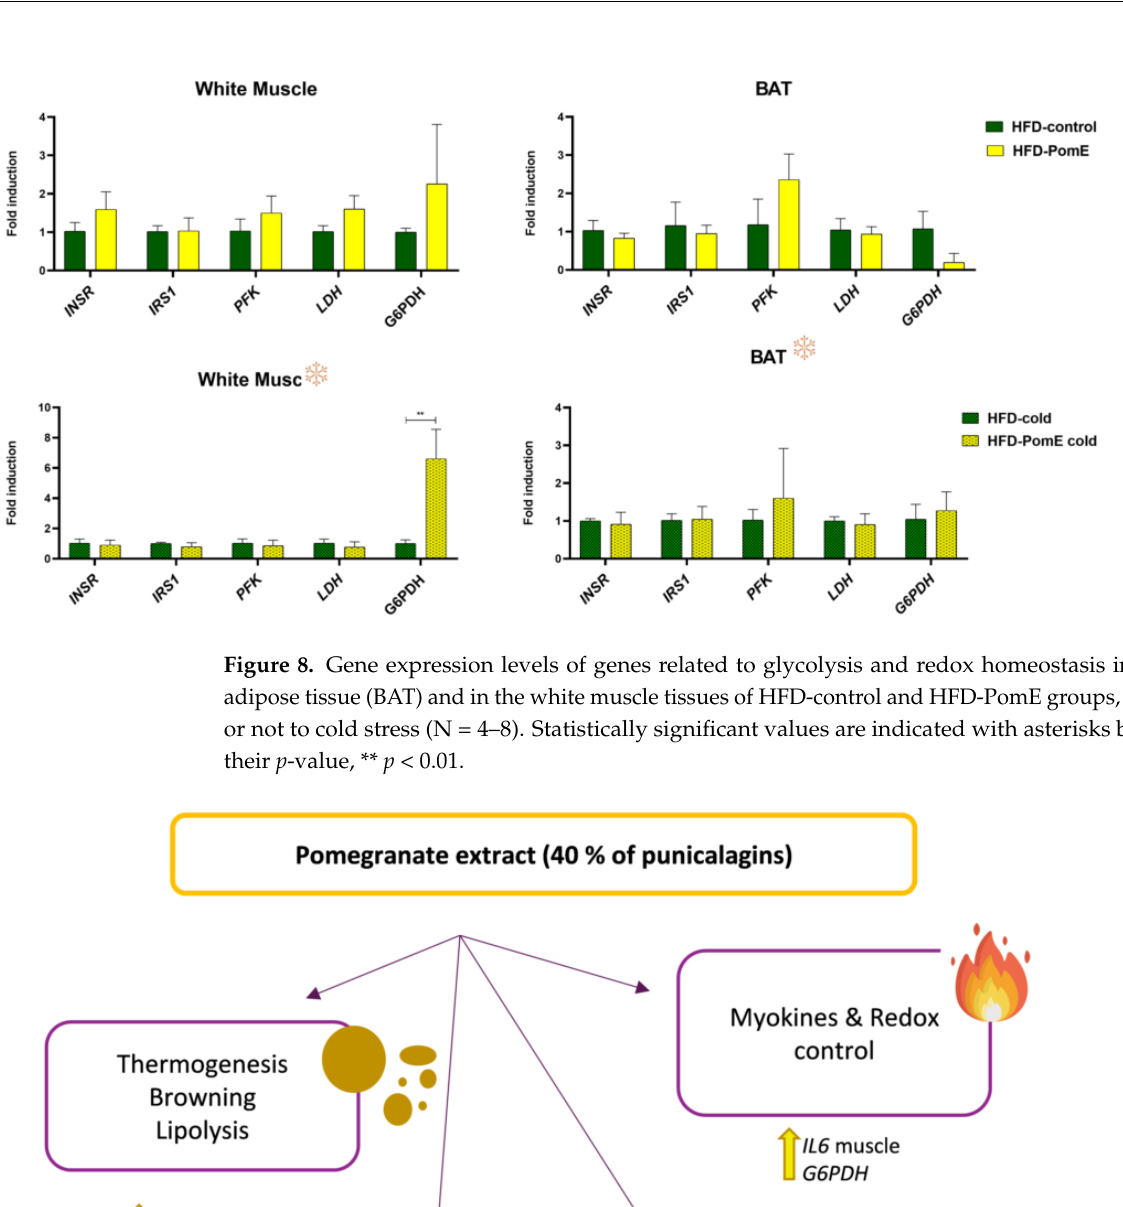
Figure 8. Gene expression levels of genes related to glycolysis and redox homeostasis in brown ad- ipose tissue (BAT) and in the white muscle tissues of HFD-control and HFD-PomE groups, exposed or not to cold stress (N = 4–8). Statistically significant values are indicated with asterisks based on their p- value, ** p < 0.01.